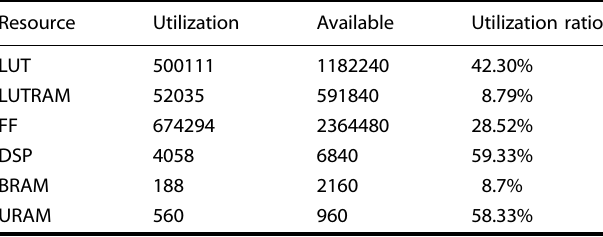
The abbreviations LUT, LUTRAM, FF, DSP, BRAM, and URAM represent Look- Up Table 110 , Look-Up Table RAM 110 , Flip-Flop 110 , Digital Signal Processor 109 , Block RAM 105 , and UltraRAM 105 ,